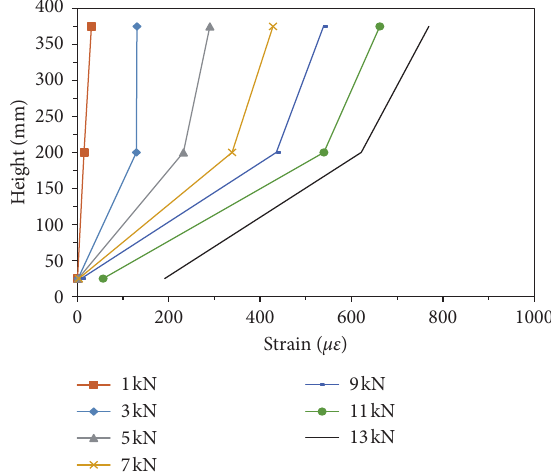
Figure 17: Strain-slip curves of direct bond specimens.